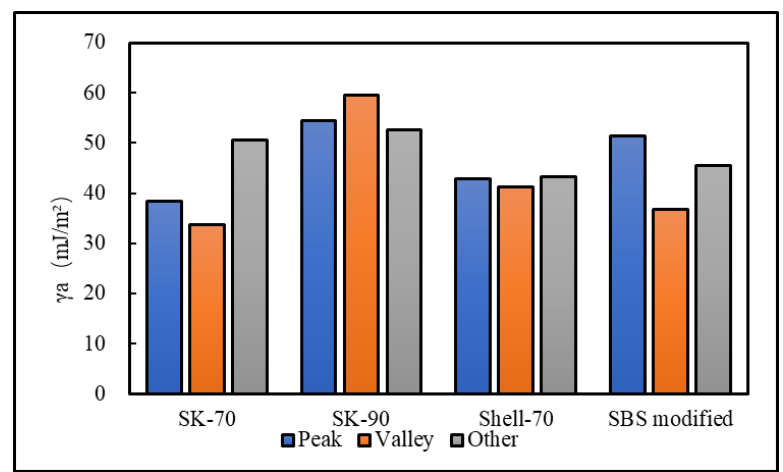
Figure 20. Surface energies of different regions of the different asphalts doped with RAA.